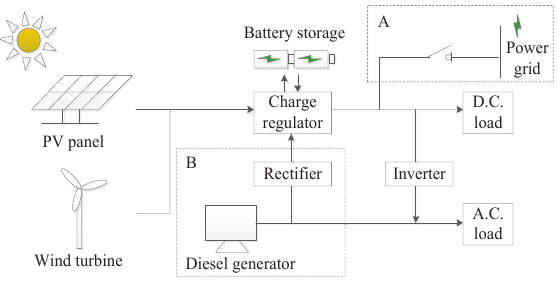
Figure 2. Illustration of the energy flow in the